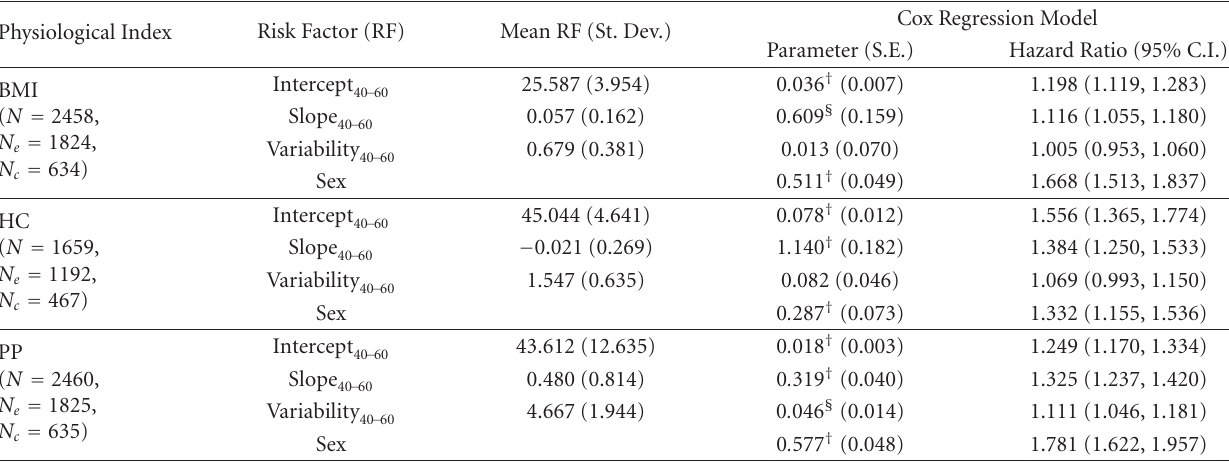
Table 2: E ff ect of “dynamic” risk factors calculated from individual trajectories of physiological indices at ages 40–60 on risk of onset of “unhealthy life” at ages 60+ in the Framingham Heart Study (original cohort) estimated by the Cox proportional hazards